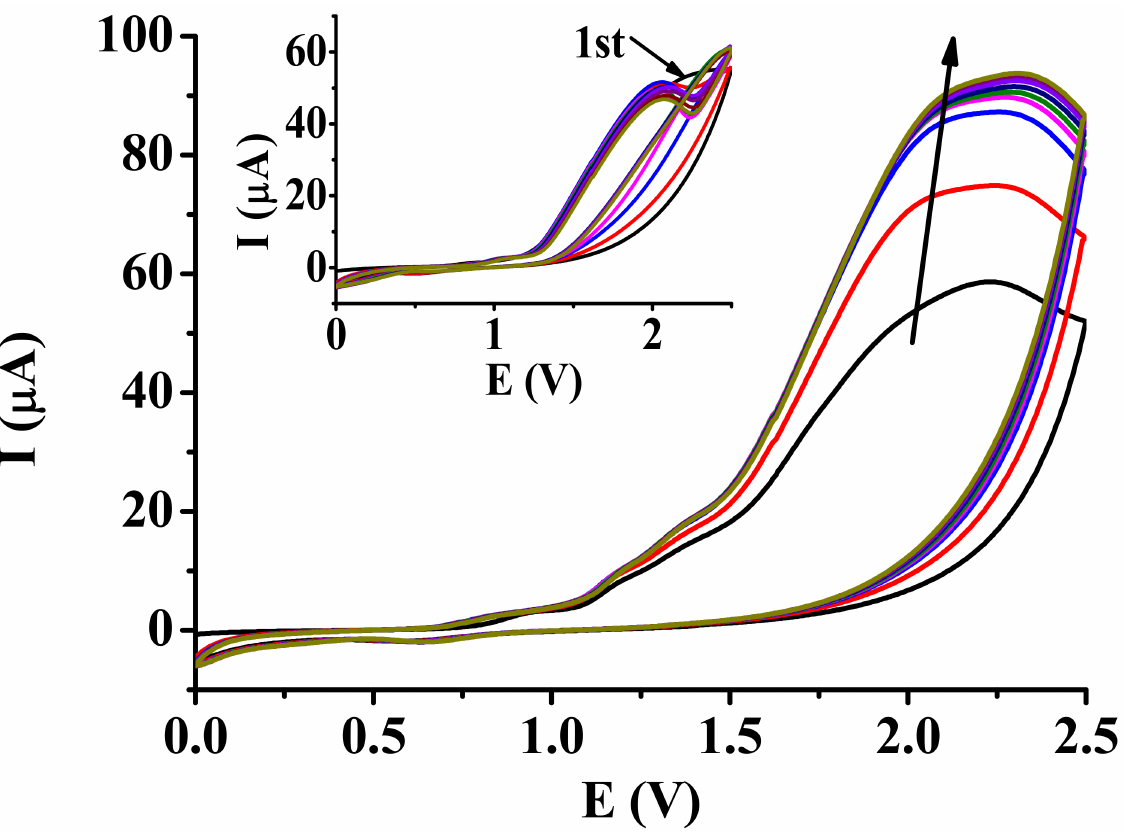
Figure 5. Repetitive cyclic voltammetric curves recorded in a solution prepared with mesityl oxide containing 20 mM 2-phenylphenol and 20 mM cavitand ( 1 ) (supporting electrolyte = 50 mM TBAP and v = 0.1 V/s; inset graph: the same as with methyl isobutyl